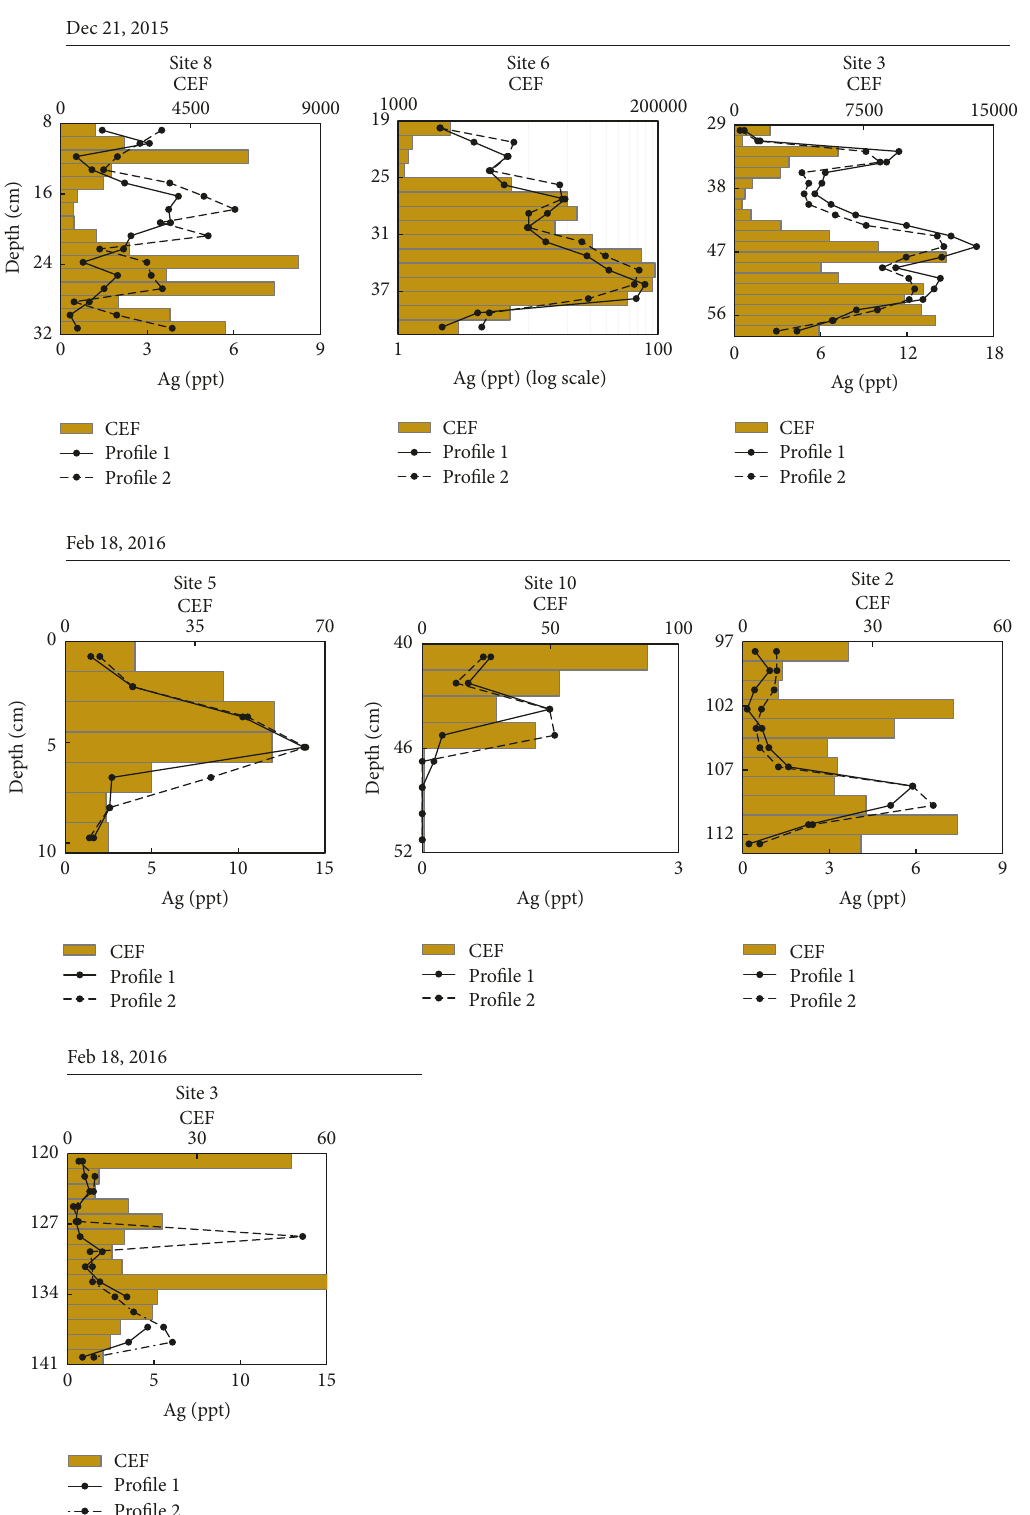
Figure 3: Results for the four spatial sampling campaigns mentioned within the target zone with at least one Ag enrichment are pictured. Solid and dotted black lines are two profiles of samples collected using the column method. Gold horizontal bars denote the enrichment factor with each